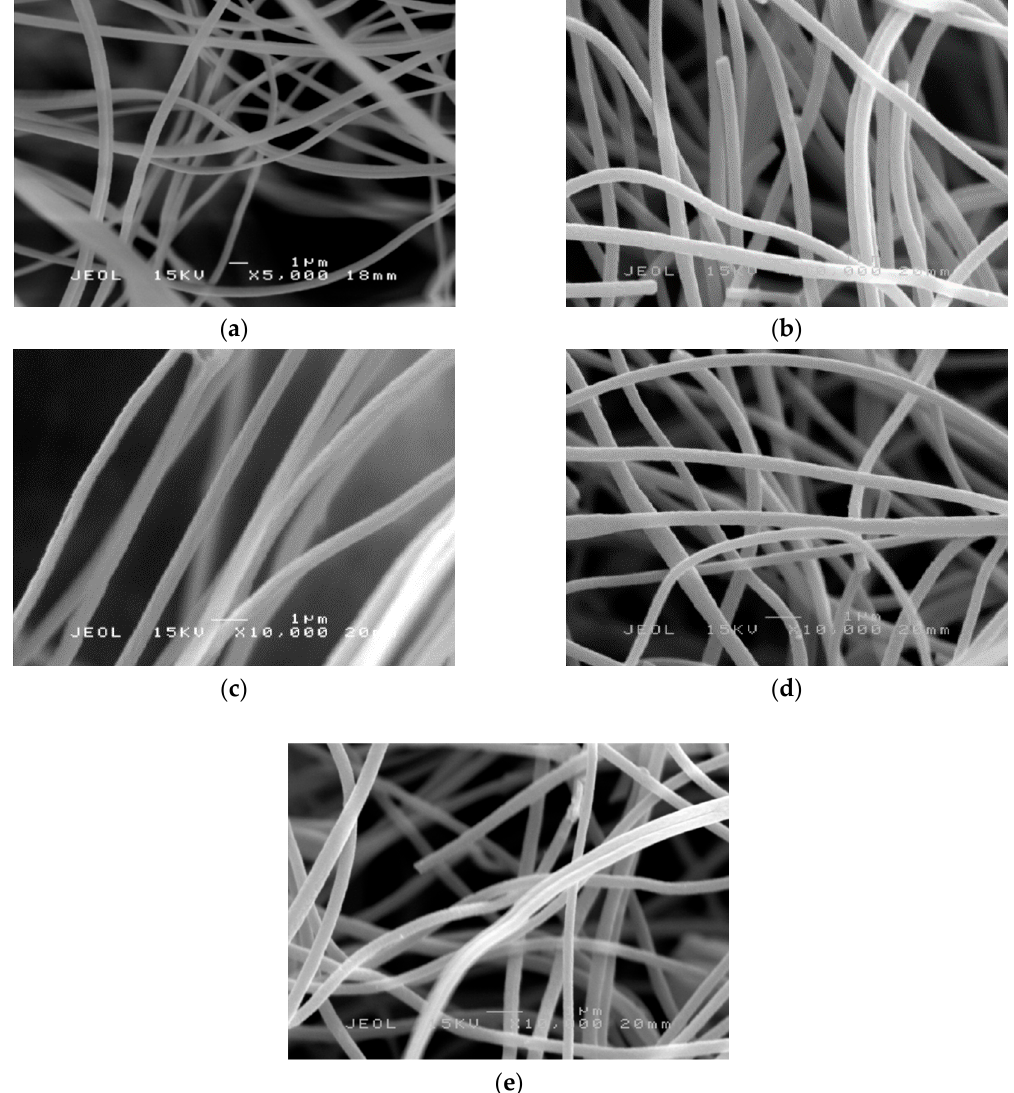
Figure 5. SEM micrographs of PAN nanofibers: ( a ) after stabilization and ( b ) after carbonization (5000× magnification), PAN/SL nanofibers: ( c ) after stabilization and ( d ) after carbonization (10,000× magnification) and ( e ) PAN/SL activated CNF.